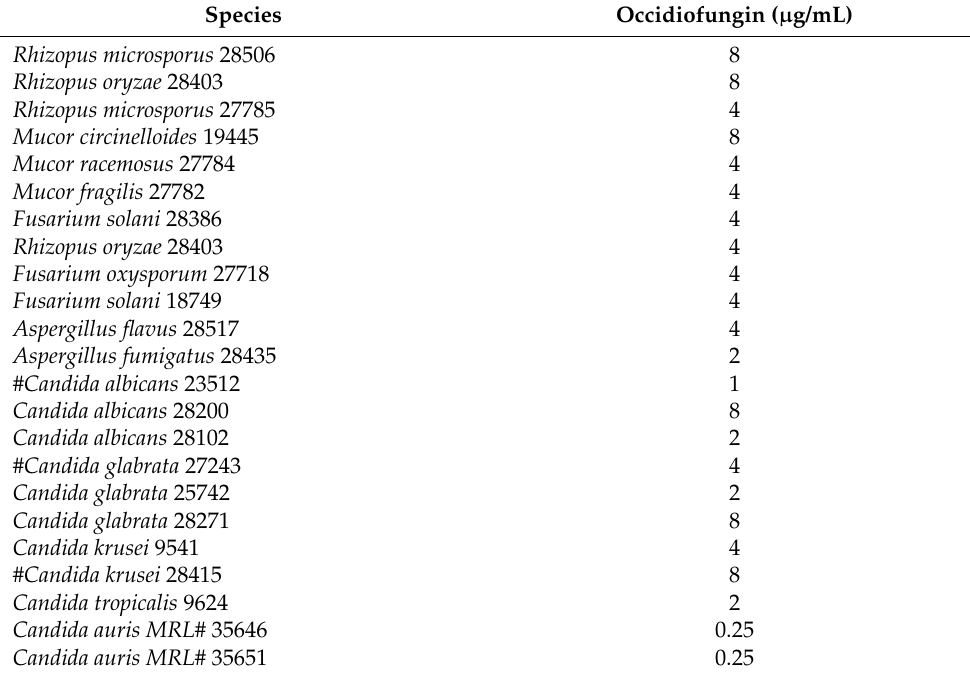
Table 2. Minimum inhibitory concentration values of occidiofungin against various fugal species. Values provided are indicative of “100%” inhibition as dictated by National Committee for Clinical Laboratory Standards guidelines. Adapted from Ravichandran et al.